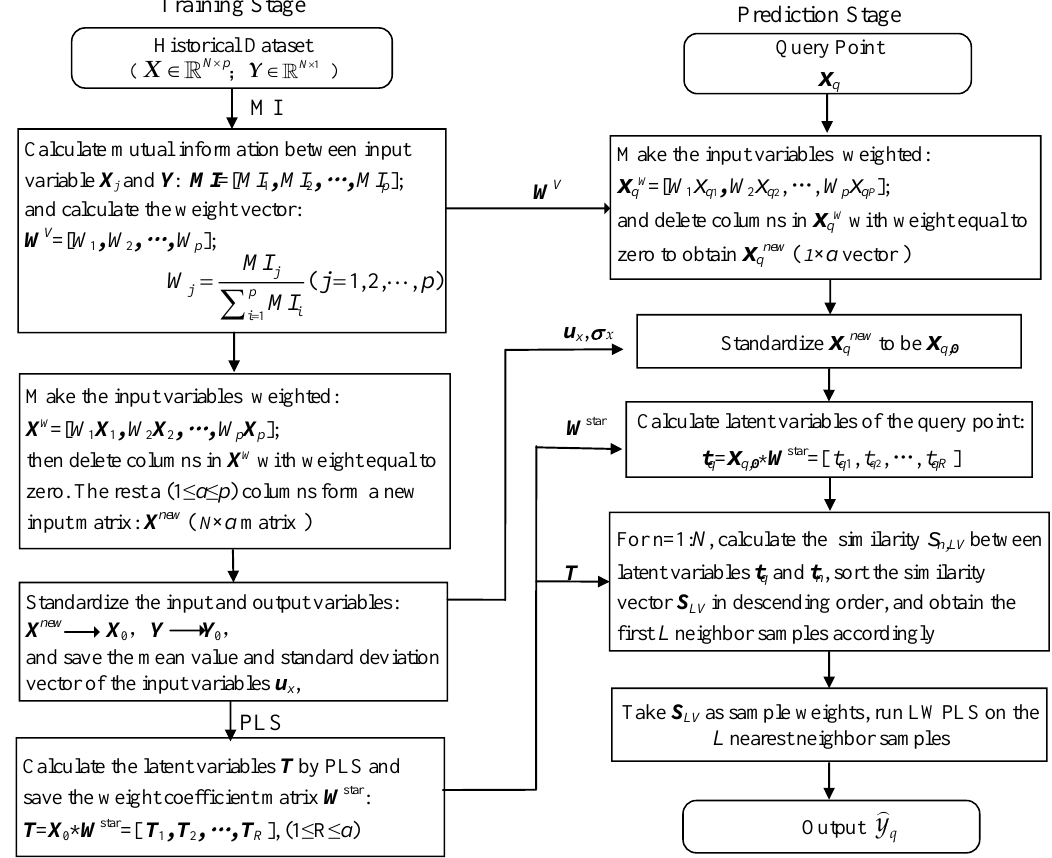
Figure 1. Two-stage flow chart of the proposed method.